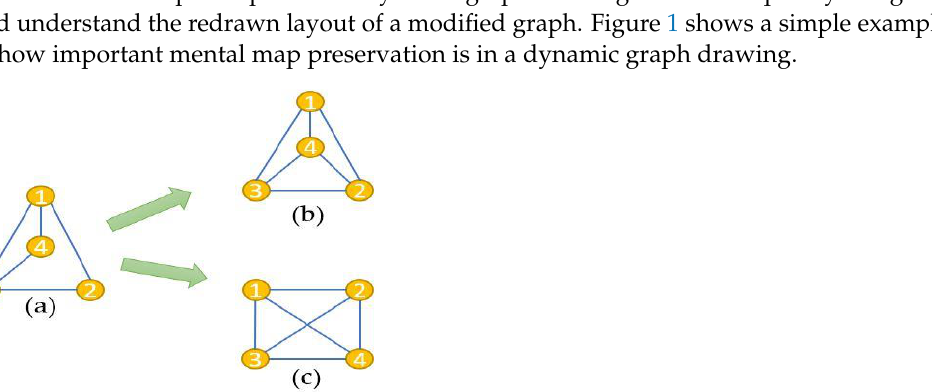
Figure 1. The importance of mental map preservation (( a )—main shape, ( b )—adding edge with mental map preservation, ( c )—adding edge without mental map preservation).